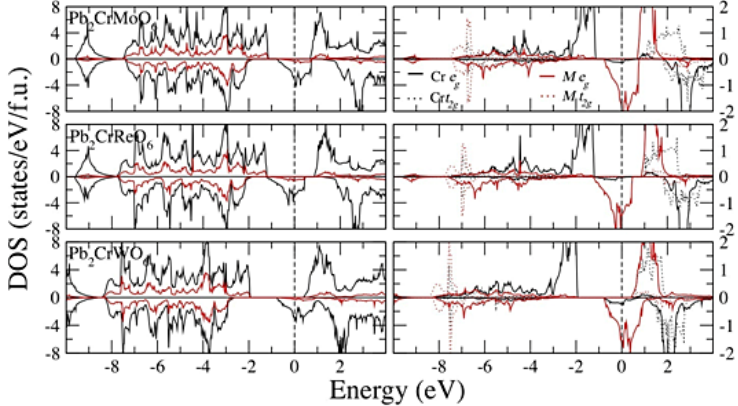
Figure 3. Calculated total, spin and site partial density of states of Pb and W) in GGA + U (3,